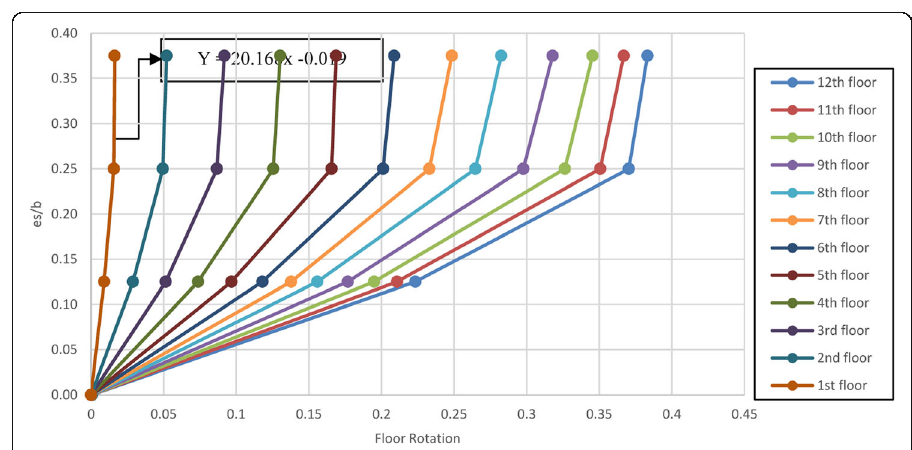
Fig. 38 Floor rotation — structural eccentricity normalized by plan dimension ( es / b ) relationship for Group- 1 (0.3 g) (color should be used for this